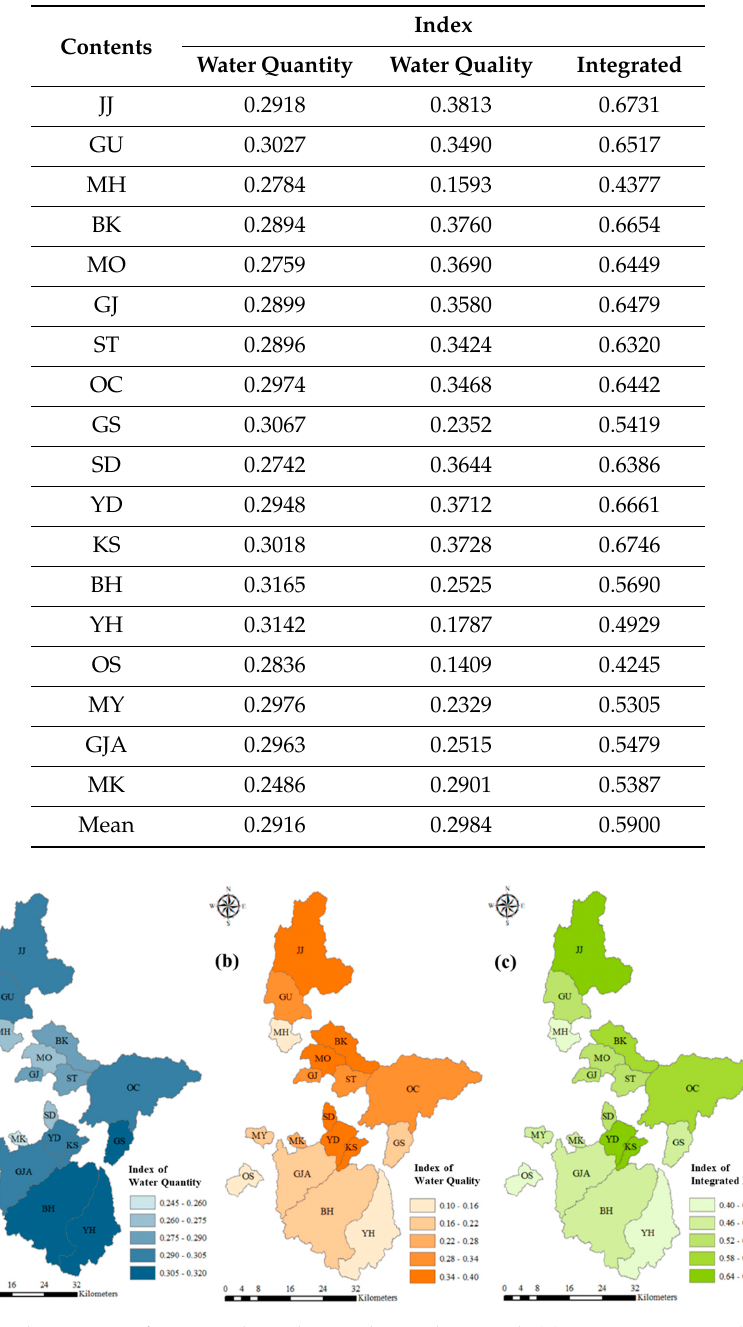
Table 15. Integrated index of water quantity and water quality by the river for 10 years.